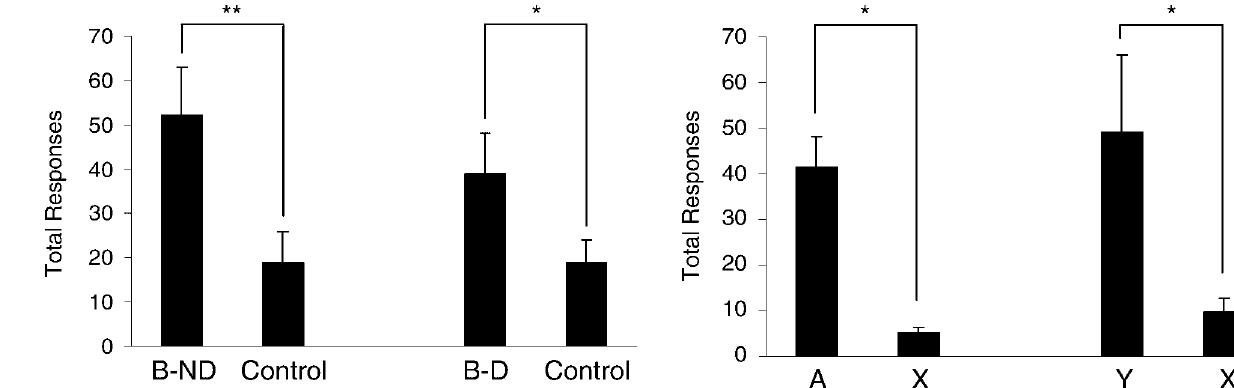
conditions in a probe test, rats responded most to the fully conditioned cues, A and B, somewhat for the partially conditioned cue, Y, and at levels comparable to the pre-CS period to the blocked cue, X. ANOVA (trial ×